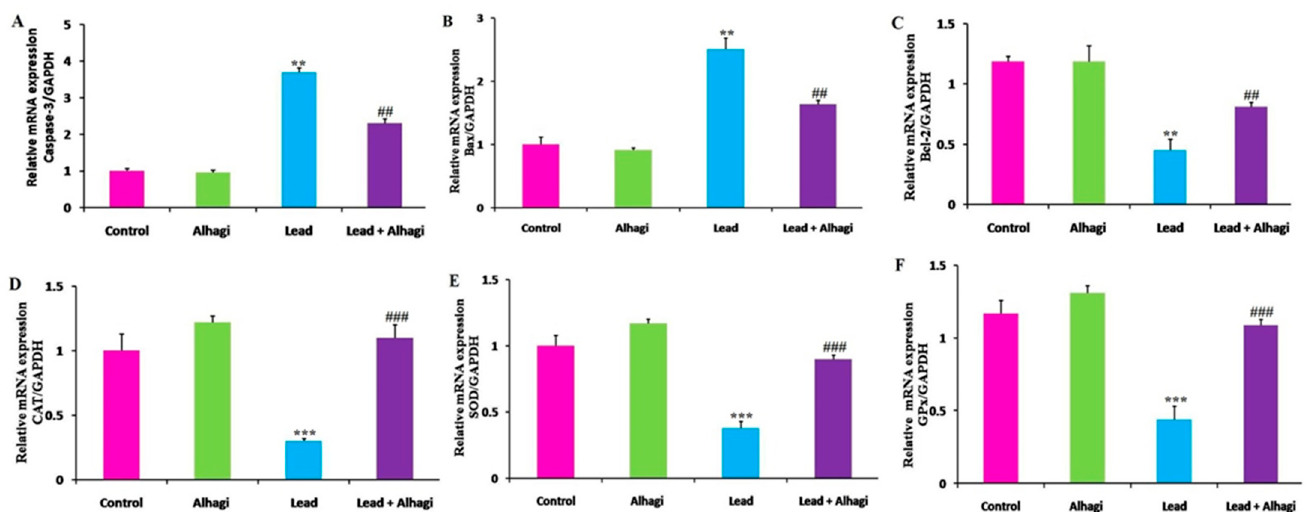
Figure 3. Effect of the A. maurorum extract (300 mg/kg BW, orally) on the hepatic mRNA expression of apoptosis-associated genes ( A – C ) and antioxidant genes ( D – F ) in rats treated with lead (100 mg/kg BW, orally) daily for 3 months. Caspase-3 ( A ), Bax ( B ), Bcl-2 ( C ), CAT ( D ), SOD ( E ), and GPx ( F ). Data were expressed as mean ± SE, n = 10 for each group. **, *** Significantly different compared to the control group at p < 0.01 and p < 0.001, respectively. ##, ### Significantly different compared to the lead-exposed group at p < 0.01 and p < 0.001, respectively.